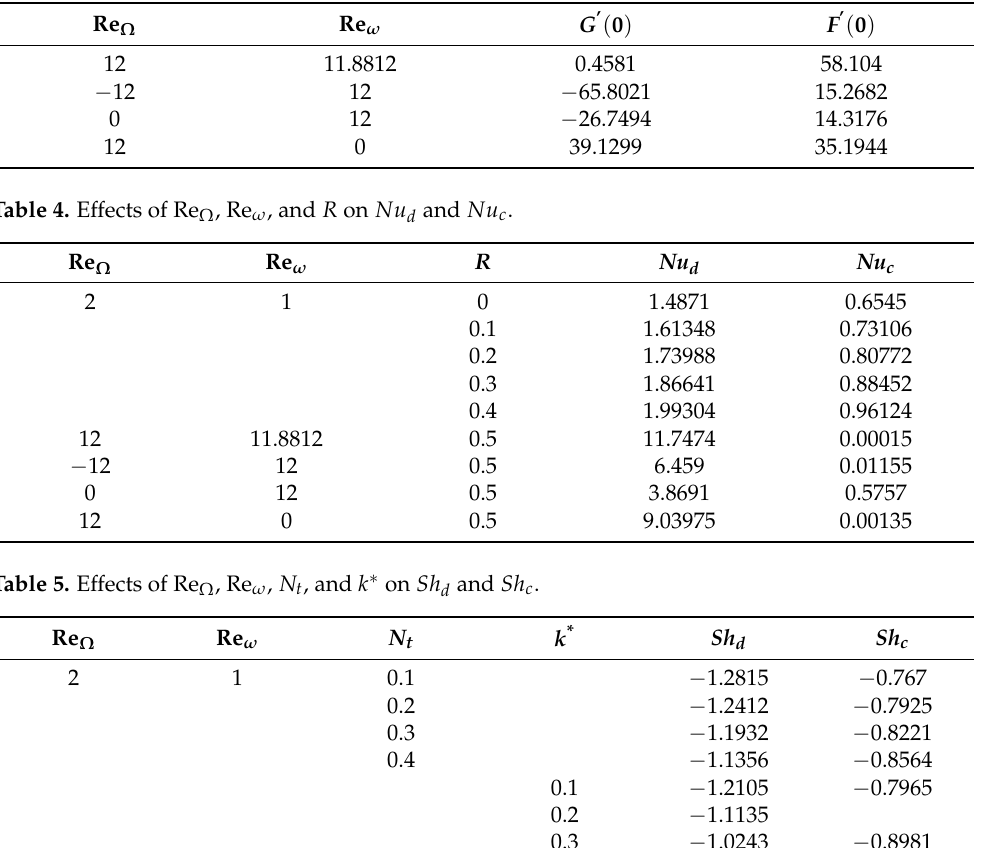
Table 3. Effects of Re Ω and Re ω on G (cid:48) ( 0 ) and F (cid:48) ( 0 ) .